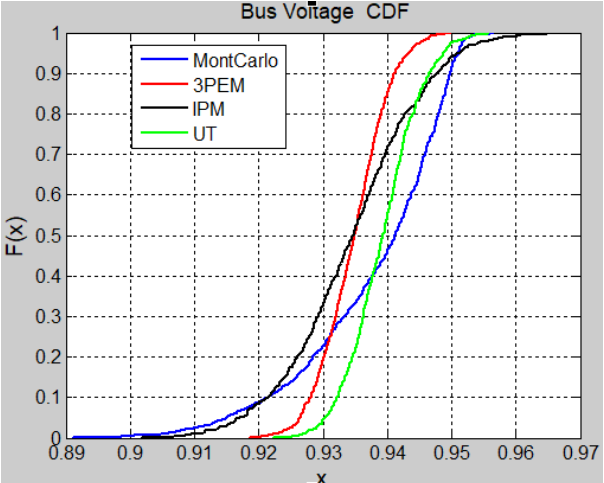
Fig. 14. The 46-bus voltage cumulative distribution function diagram